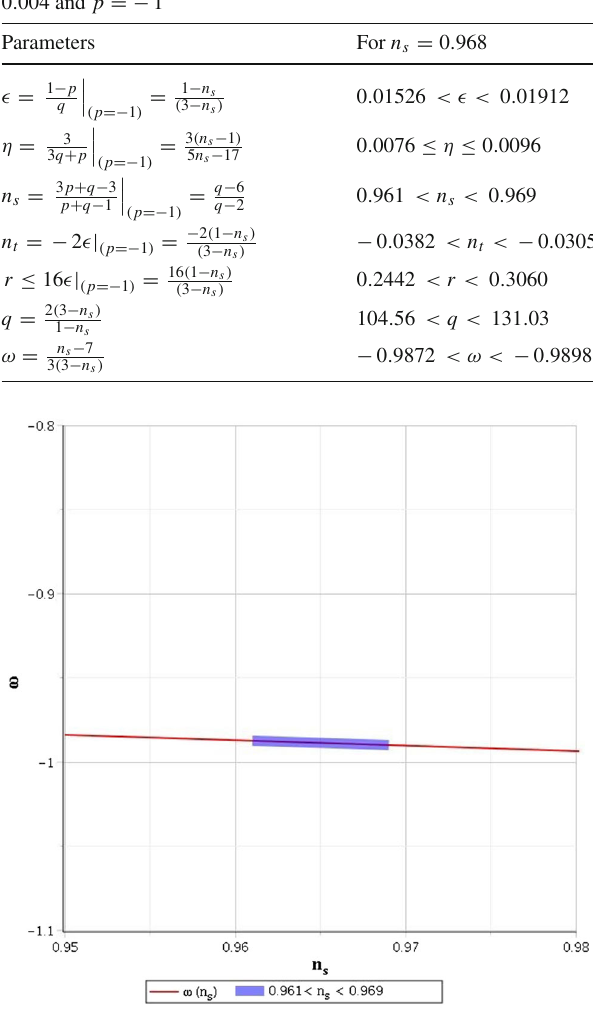
Fig. 1 Plot of the range of ω( n s ) -values for Planck 2018 data